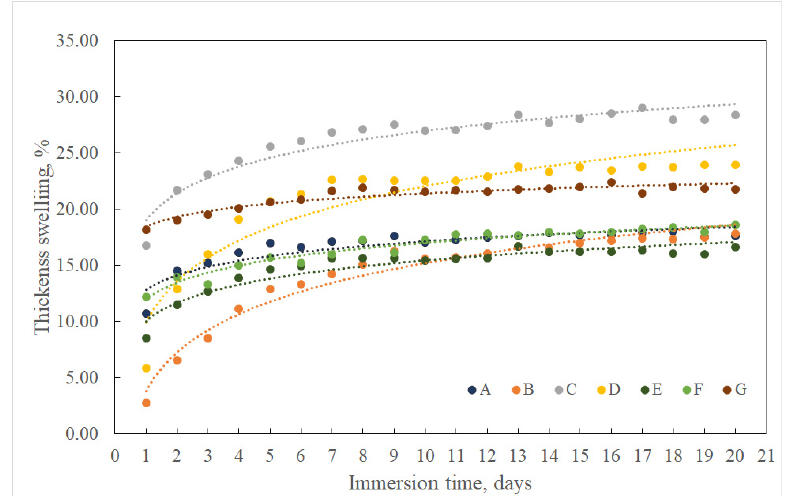
Figure 3. Relationship between immersion time and thickness swelling of particleboard samples with dimensions 10.0 × 10.0 cm for all categories (A–G).